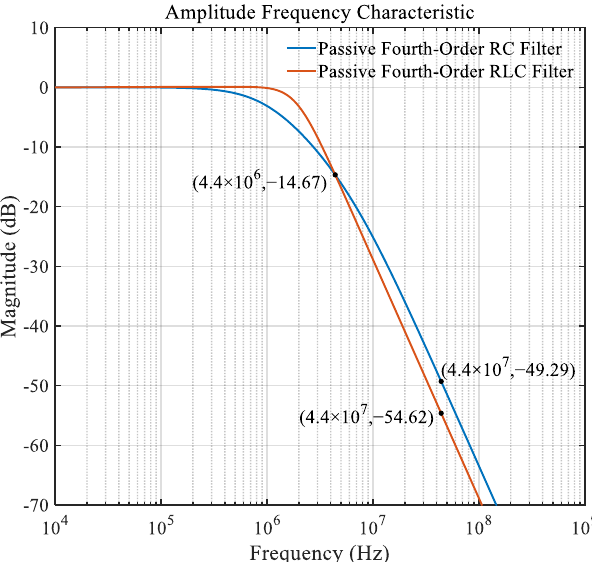
Figure 5. Amplitude-frequency response characteristic curve.